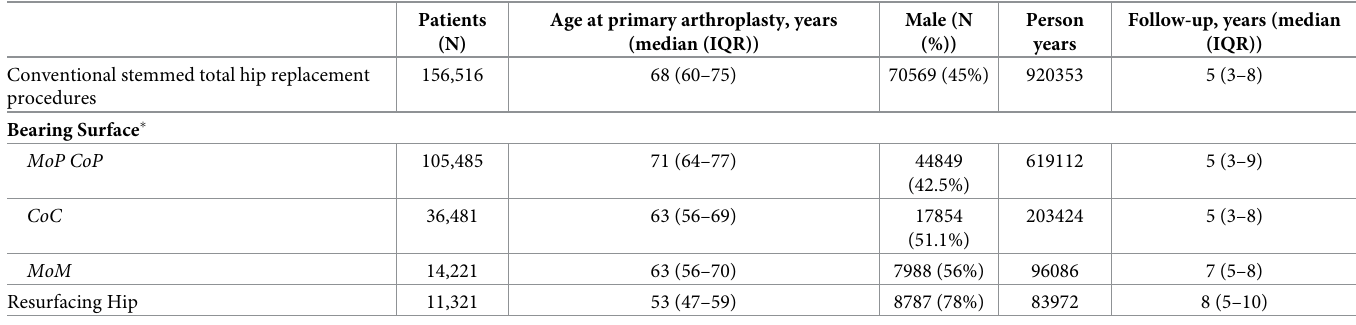
Table 1. Demographic characteristics of patients undergoing conventional stemmed THA or resurfacing THA by bearing surface.